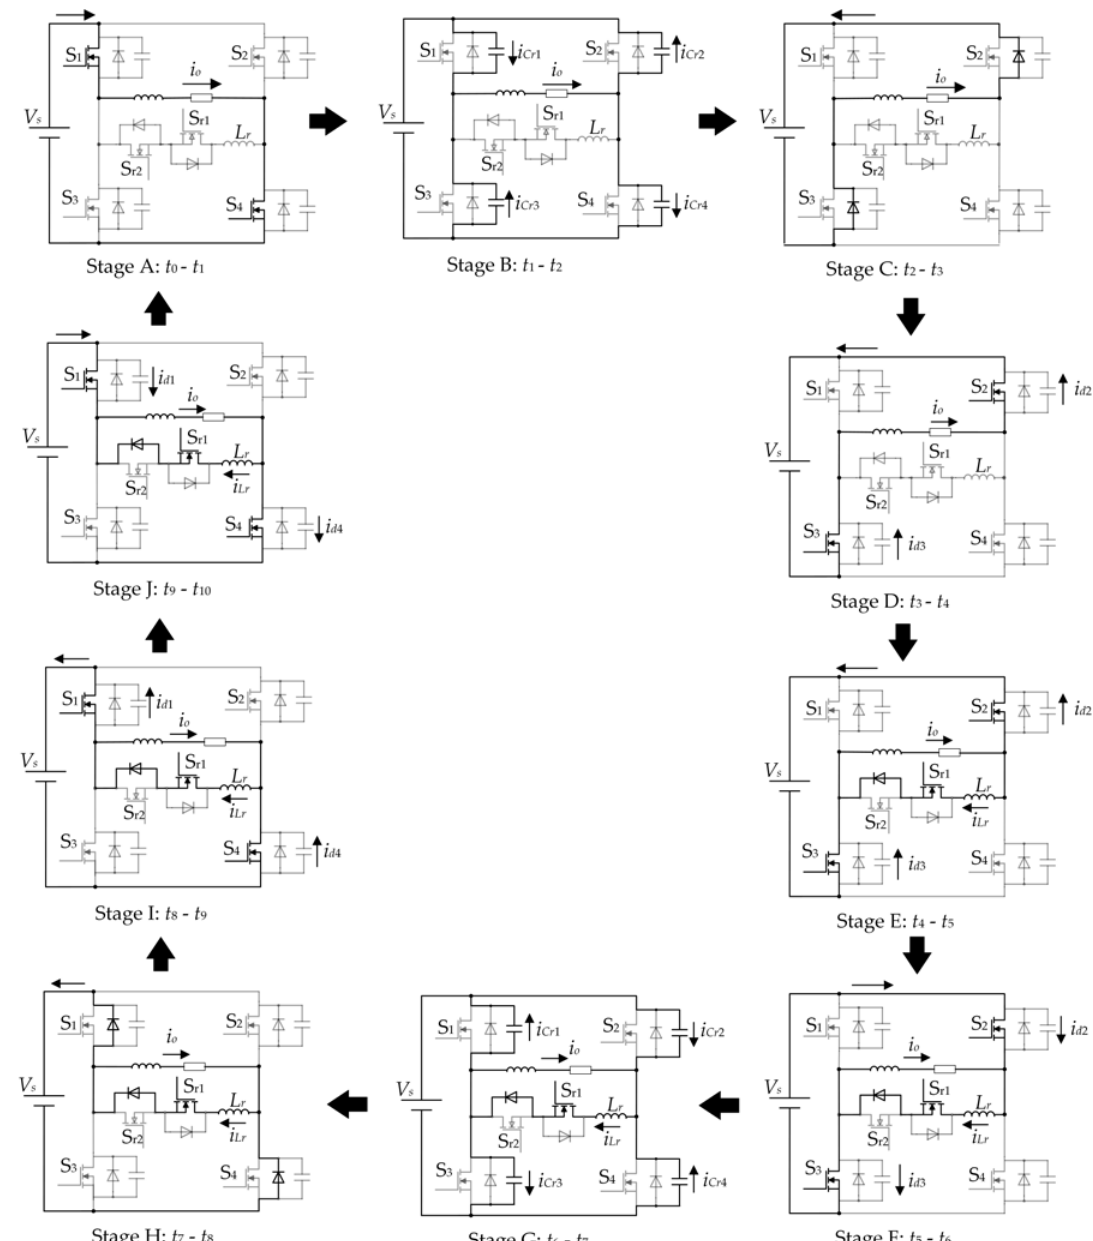
Figure 2. The operating stage when the output current is positive.